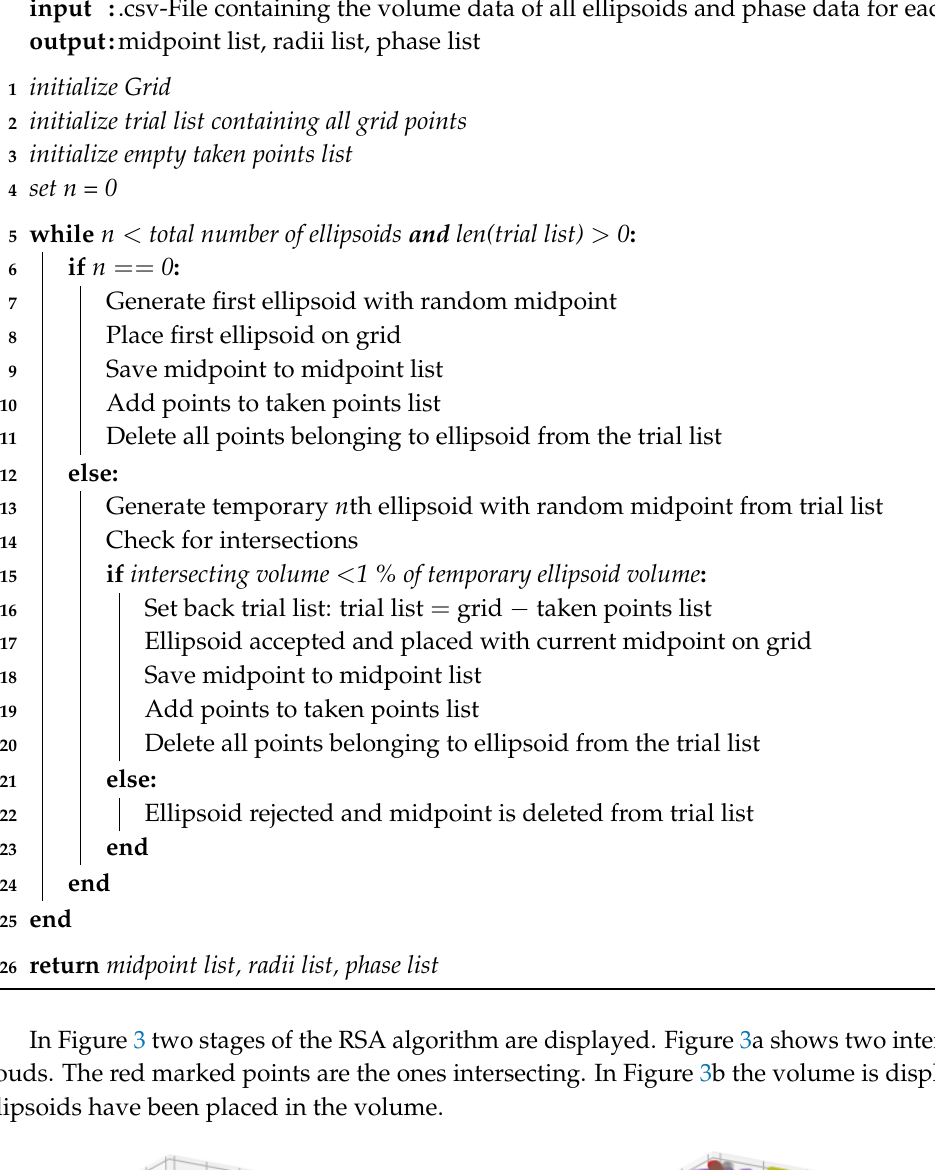
Algorithm 1: Discrete Random Sequential Addition Algorithm